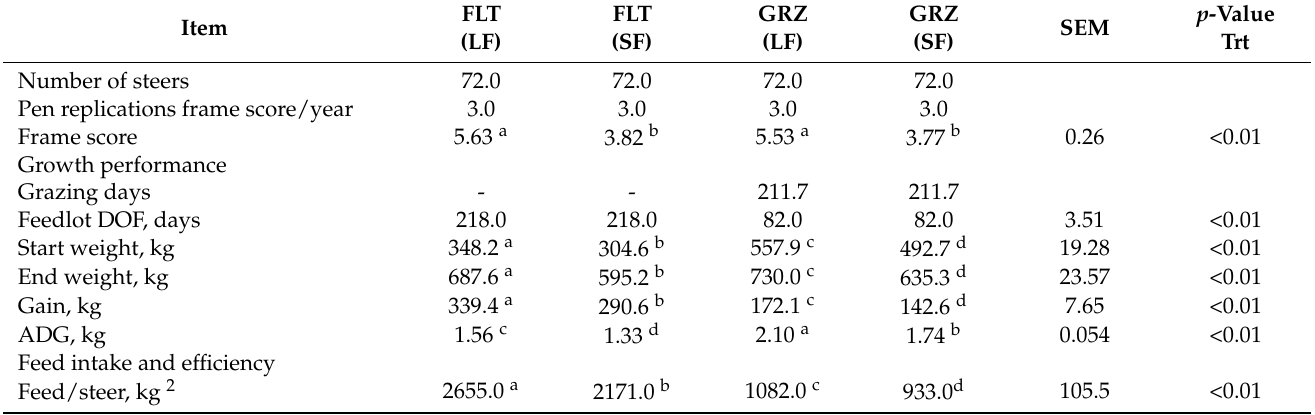
Table 6. Effect of beef steer frame score and extended grazing on feedlot finishing performance, efficiency, and economics 1